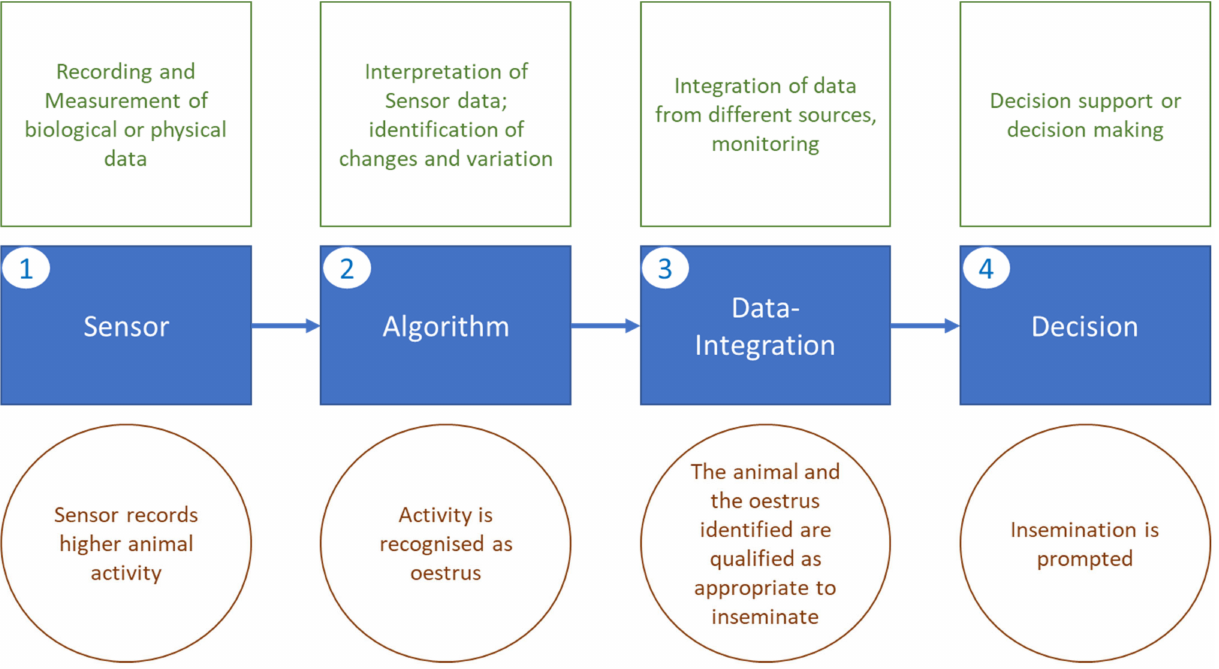
Figure 3. Elements of Precision Livestock Farming, adapted from Rutten et al. [14]. While sensors are measuring parameters, algorithms are recognizing relevant changes and interpreting them (here with the example of estrus detection). Additional information from other sources helps to classify the event. The final stage is a system that autonomously acts on the basis of the information—in this example, it decides on inseminating the